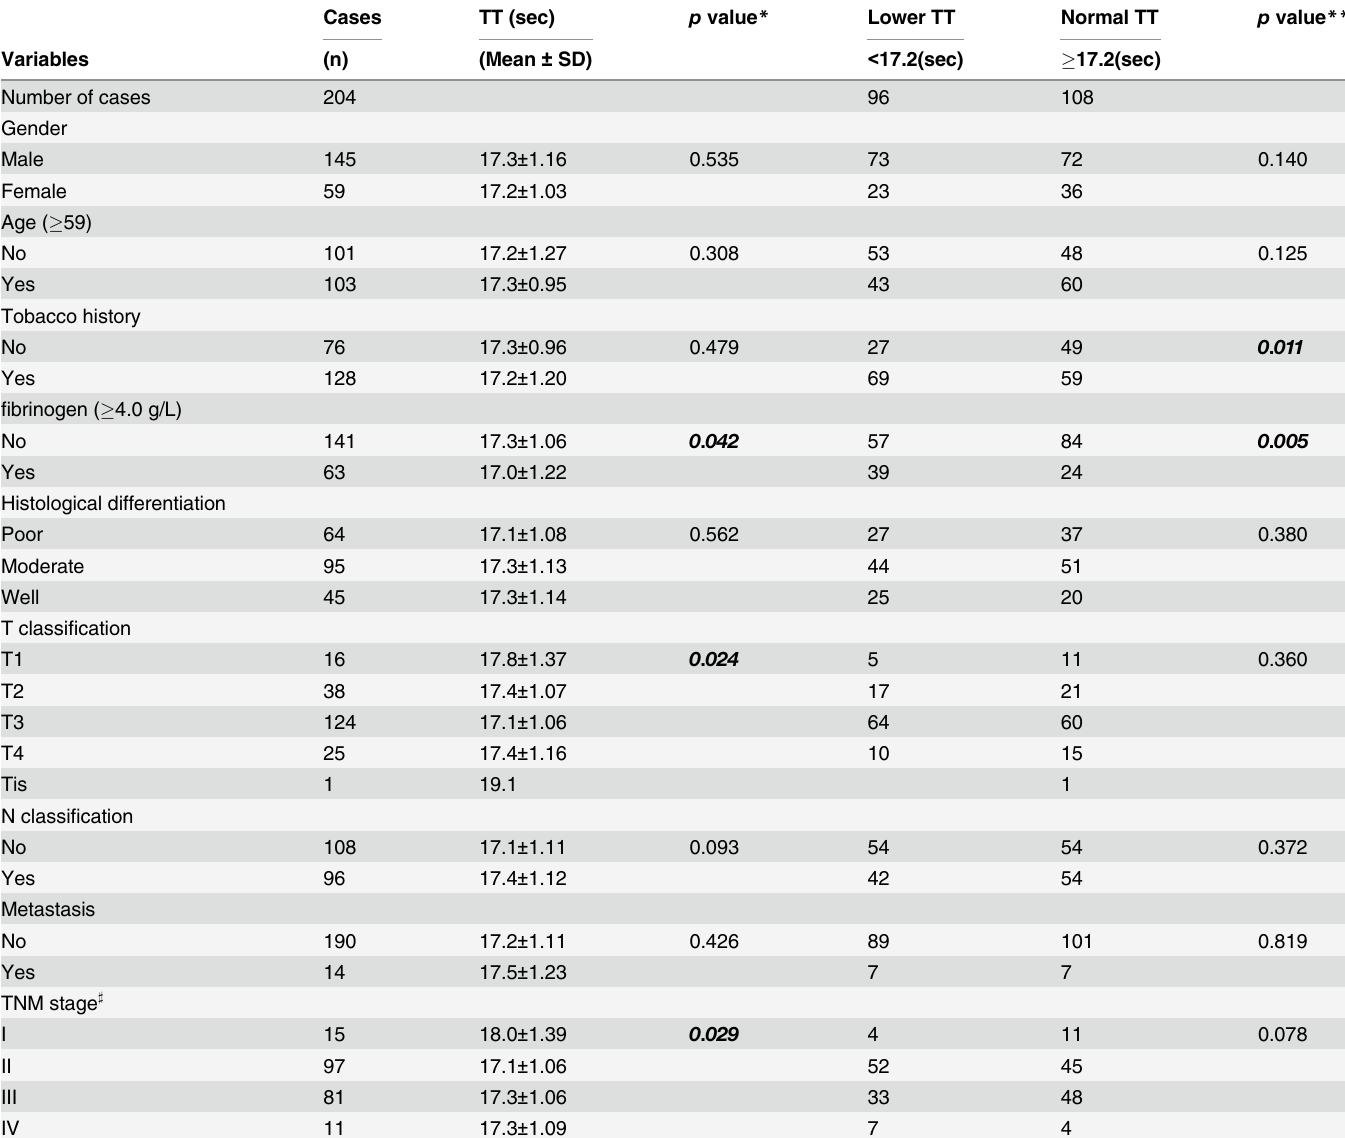
Table 4. Relationship between the TT and the clinical characteristics in 204 patients with ESCC.